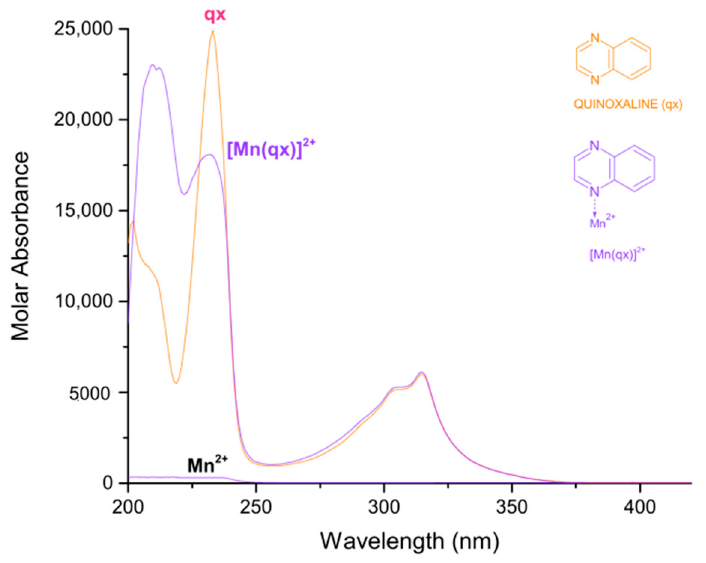
Figure 2. Calculated electronic spectrum of manganese(II)–quinoxaline in methanol:quinoxaline (qx), Mn 2+ and [Mn(qx)] 2+ .